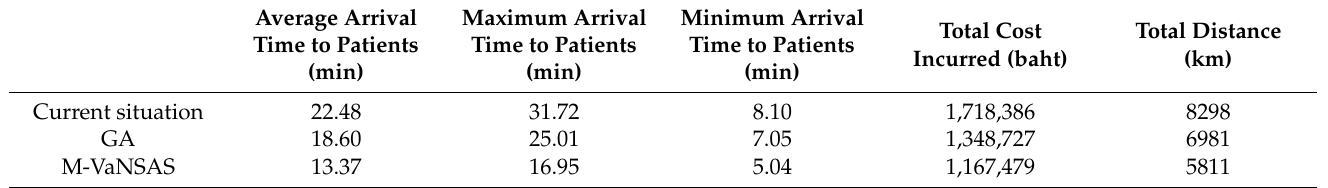
Table 16. Comparative results of the current situation and the proposed